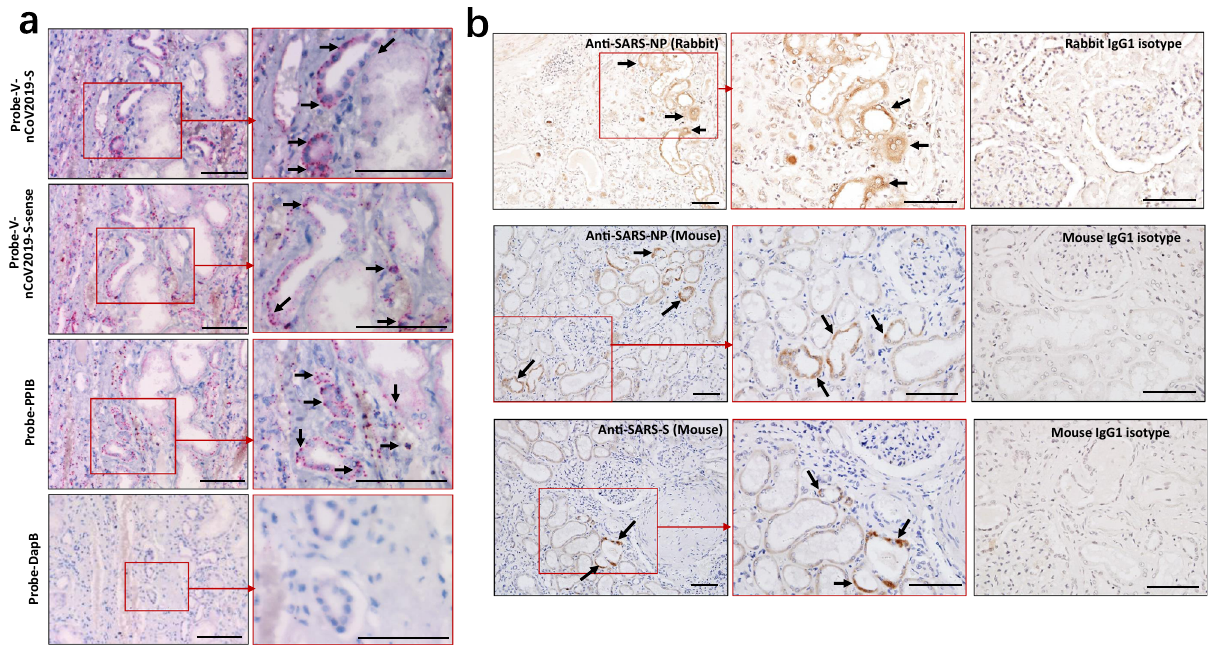
Fig. 2 Detection of SARS-CoV-2 viral RNA and protein antigens in kidney tissues. a RNA in situ hybridization (ISH) in serial sections of kidney tissues from COVID-19 post-mortem (case #2) showed reactivity for the presence of SARS-CoV-2 viral RNA and the positive control probe to the housekeeping gene peptidylprolyl isomerase B (PPIB). Scale bars = 100 μ m. b The kidney tissues from COVID-19 post-mortem (case #2) were incubated with primary anti-SARS-NP (nucleocapsid protein) antibodies (clone ID: 019, rabbit IgG; Sino Biological), anti-SARS-NP antibodies (ab273434, mouse monoclonal 6H3, Abcam), anti-SARS-S (spike) antibodies (ab273433, mouse monoclonal 1A9, Abcam), or only incubated with mouse or rabbit IgG1 control antibodies, and the expression of indicated viral antigens were further analyzed by immunohistochemistry. Arrow indicates positive tubules. Scale bars = 100 μ m. Data represent one of at least three technical replication each.